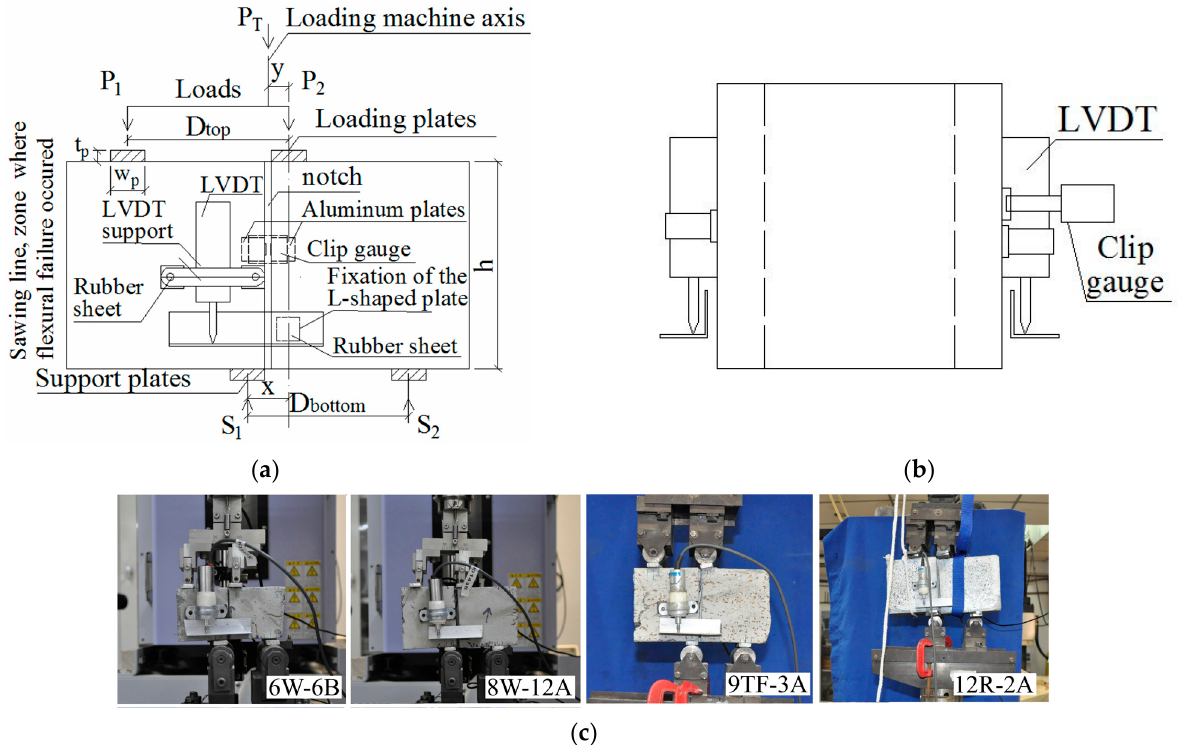
Figure 5. Setup based on the FIP test [38]: ( a ) front side of the test setup (the rear side has an equal setup with the addition of a clip gauge, as shown in the dashed line); ( b ) side view of the test setup; ( c ) tests at different loading stages.